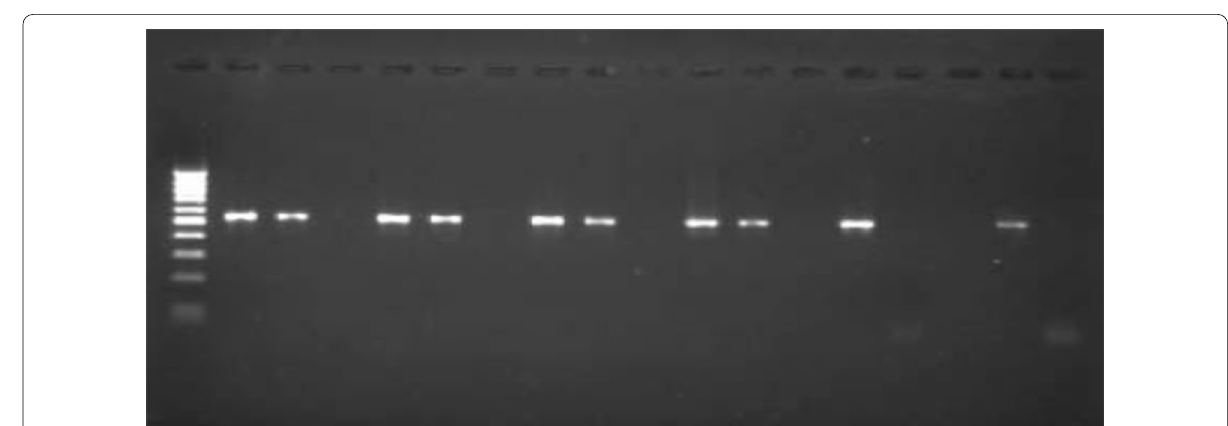
Fig. 2 The UV illuminated image of 16 s RNA gene (534 bp) of H. pylori amplified by